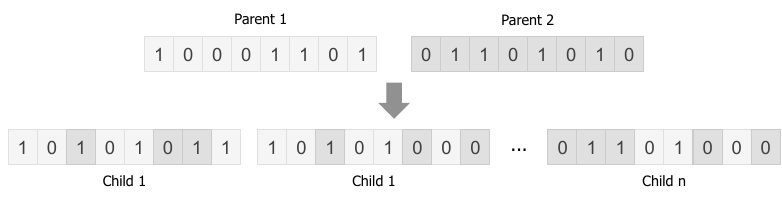
Figure 3. Uniform crossover: bitwise reproduction.